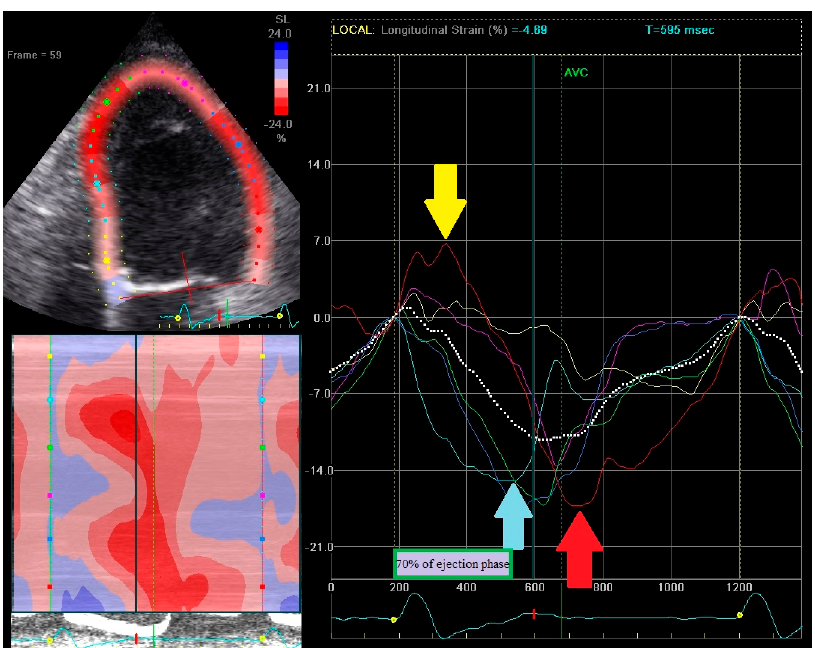
Figure 2. RSPI calculation: 4-chamber view. In 4-chamber view patient reached 3 points: early contraction of the midventricular segment (light blue line; light blue arrow) in the interventricular septum [1 point] but peak contraction slightly exceeds 70% of the systolic ejection phase [0 point]; early prestretching of the basal segment (red line; yellow arrow) in the lateral wall [1 point] with the peak contraction (red arrow) after aortic valve closure [1 point].